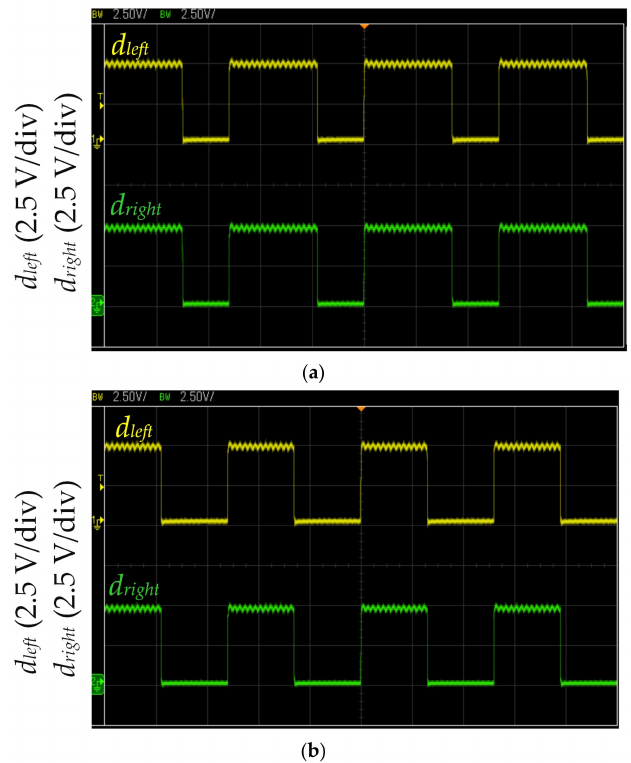
Figure 12. Measured MCU output d left and d right waveforms during straight-line running: ( a ) with proposed LCOT control strategy and ( b ) with fixed duty cycle method. (The horizontal axis: 2 µ s.)